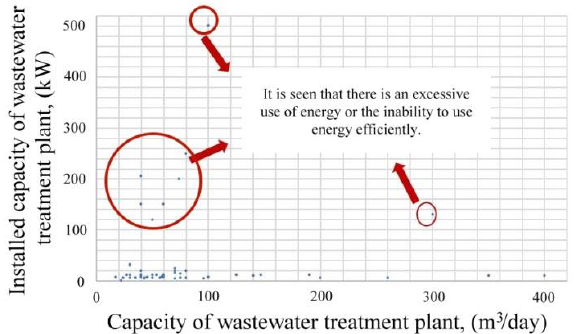
Figure 7. Impact of treatment plant capacity